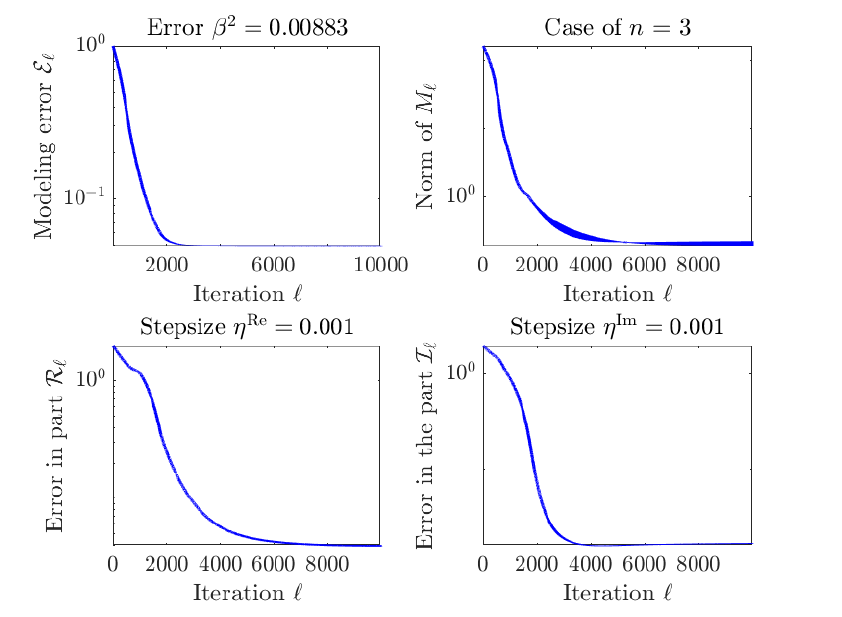
Figure 7. Results of a numerical experiment by the Riemannian-gradient-based geodesic-stepping optimization algorithm in the case that n = 3.